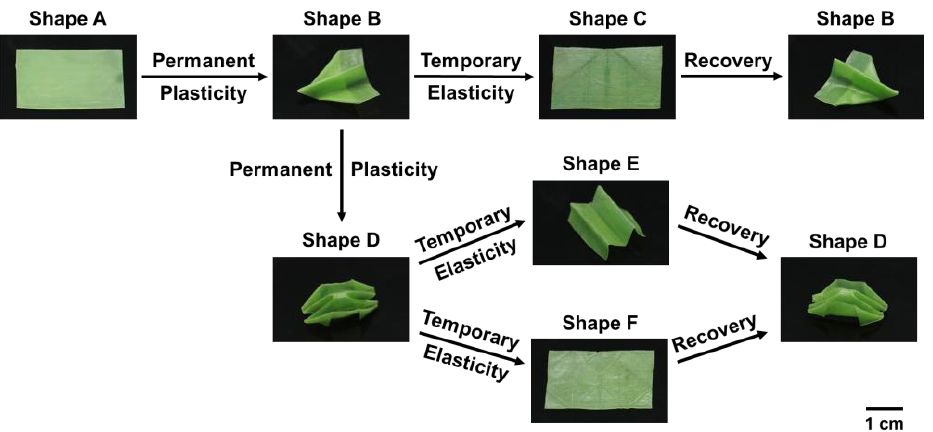
Figure 7. The diverse shape-shifting behaviors via a metallo-supramolecular shape-memory film. Physical metallo-supramolecular interactions further provide the networks with self-welding properties that can create more complex forms via assembly. As indicated in Figure 8a, the mechanical properties of films before and after welding are very similar, revealing good self-welding capabilities. Thus, as shown in Figure 8b, we programmed the planar films into a windmill shape and a shaft shape, respectively, by solid-state plasticity. The two parts were further assembled into a windmill tower through thermo-induced self-welding. In this way, more sophisticated shapes can be established beyond conventional origami [37].